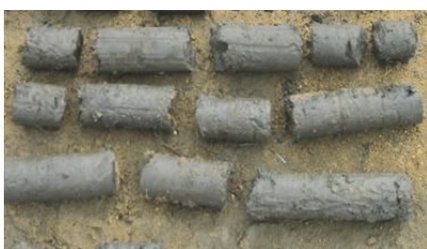
Figure 15: Core sample of cement-soil on